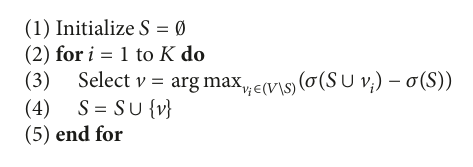
Algorithm 1: Basic greedy